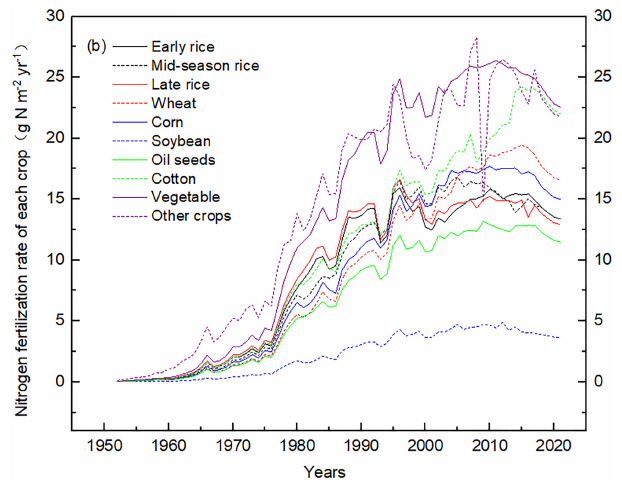
Figure 4. Total nitrogen fertilizer input in major crop types from 1952 to 2018 (TgNyr − 1